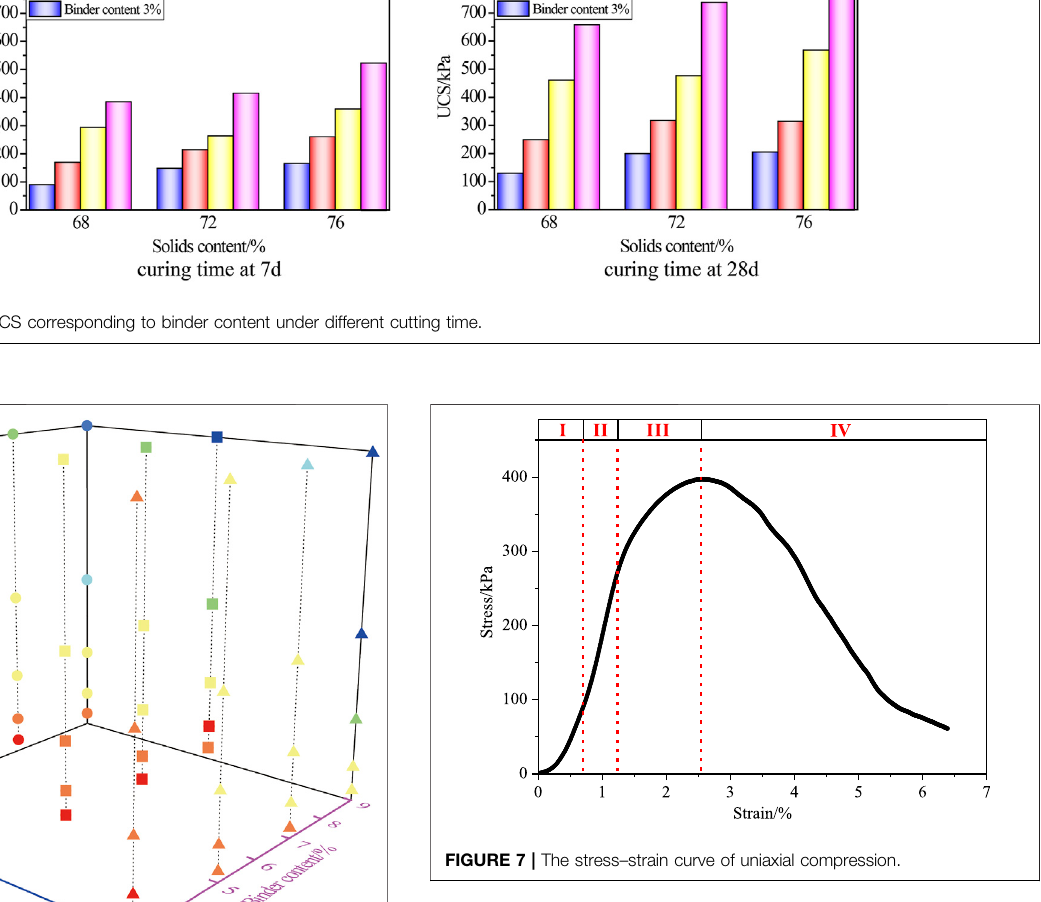
The larger values of UCS are concentrated in the upper right area and reach the maximum UCS in this area. shows the sensitivity of UCS to the factors due to changes in UCS to the three is evaluated by de fi ning the sensitivity coef fi cient S . Since the value ranges and spans of the curing time (1 – 28 days), binder content (3 – 9%), and solid content (68 – 72%) are not within the same scale, the normalized